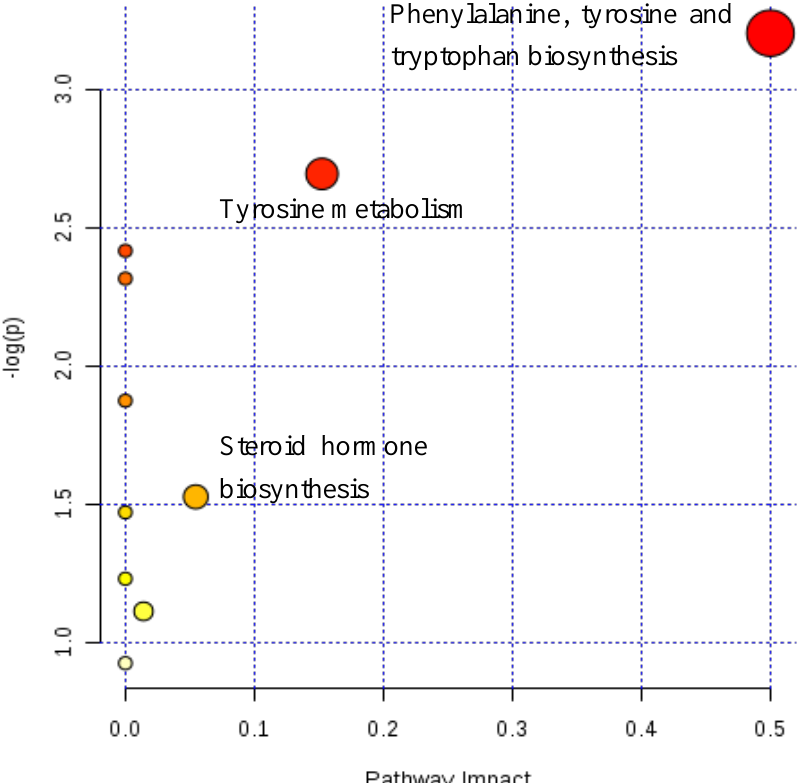
Figure 3. A systemic view of the disordered metabolic pathways associated with hair loss or finasteride treatment groups in this study. The colors (varying from yellow through to red) indicate that the metabolites were in the data with different levels of significance, red indicating a more significant pathway than those indicated by yellow circles. All metabolic pathways have been described according to p- values from the pathway enrichment analysis (y-axis) and pathway impact values from the pathway topology analysis (x-axis). Table 1. Concentration of four androgens and three estrogens in urine samples from patients with pattern baldness who have been taking finasteride for one year and from healthy controls (ng / mg